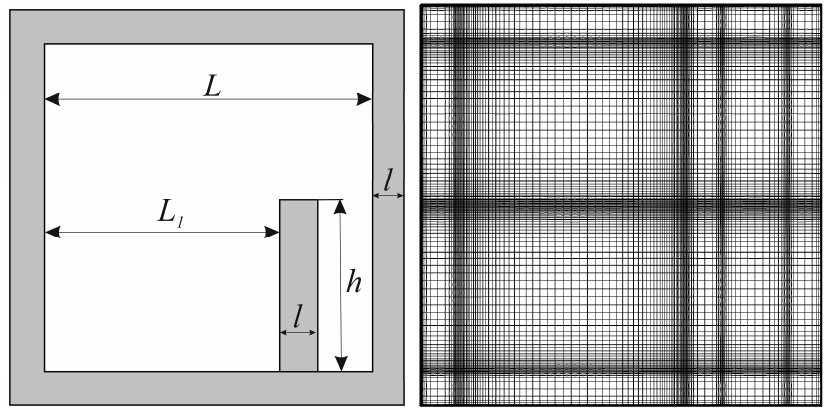
Figure 2. Computational region and used grid.